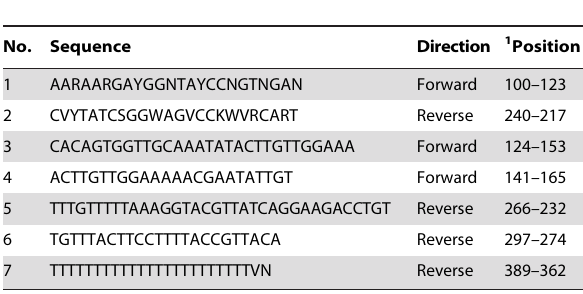
Table 1. Primers for Amplification of cDNA Encoding